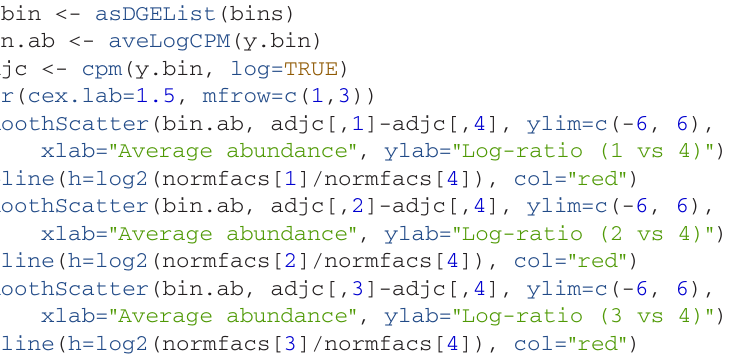
ground regions. A non-zero log-fold change for these bins indicates that composition bias is present between libraries. The red line represents the log-ratio of normalization factors and passes through the centre of the cloud in each plot, indicating that the bias has been successfully identified and